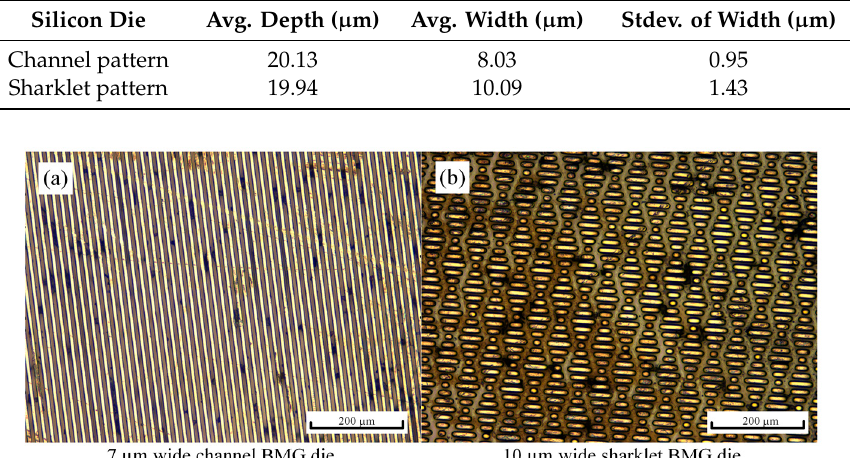
Figure 4. Characterizations of the textured bulk metallic glass (BMG) dies: ( a ) the micro-channels and ( b ) the sharklet patterns.